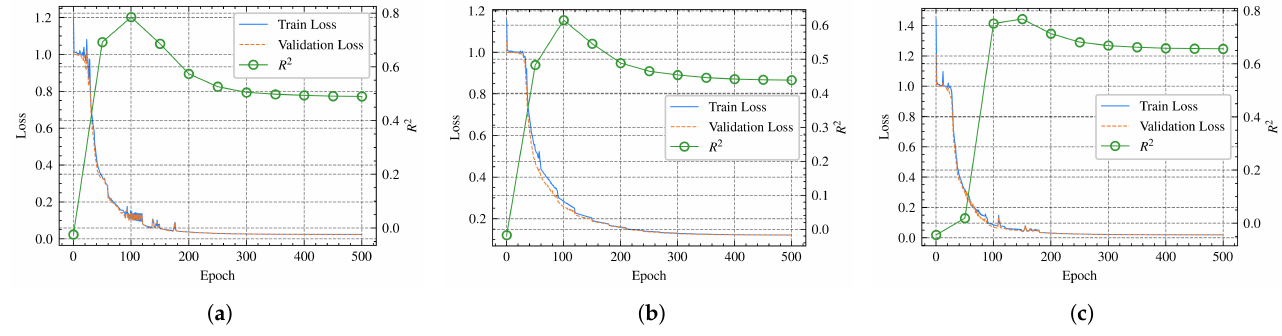
Figure 7. Curve of doss during model training and R 2 changing on test set. ( a ) The changes in the loss of the model on average grain size. ( b ) The changes in the loss of the model on twin boundaries density. ( c ) The loss curve of the model on an average surface. The blue curve in the figure represents the loss curve on the training data set and the orange curve represents the loss curve on the validation data